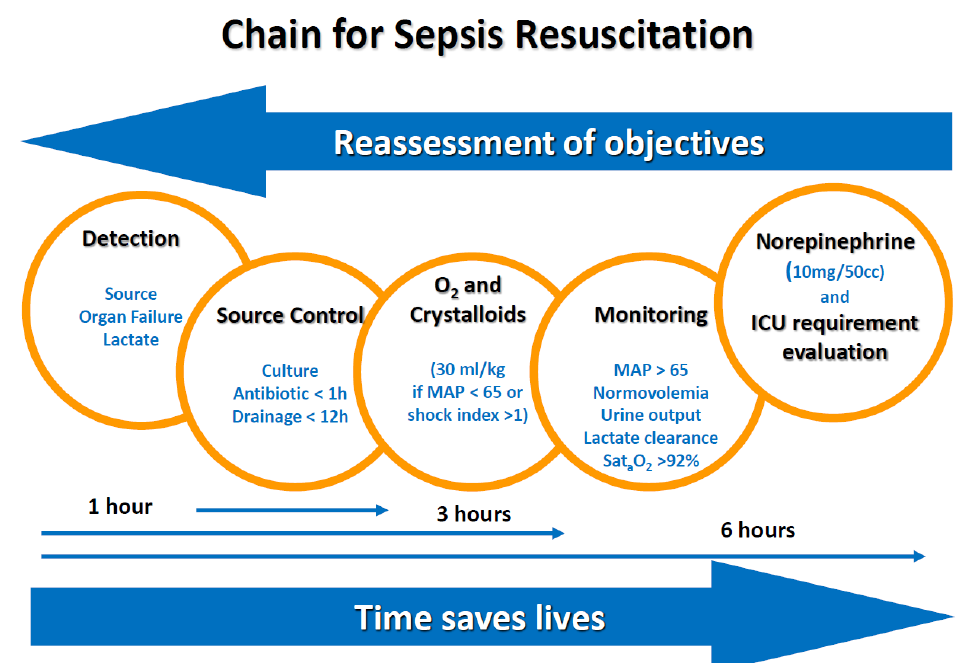
Figure 1. Chain for sepsis resuscitation that resumes the clinical algorithm for initial management of septic patients. ICU—intensive care unit; MAP—Mean Arterial Pressure.